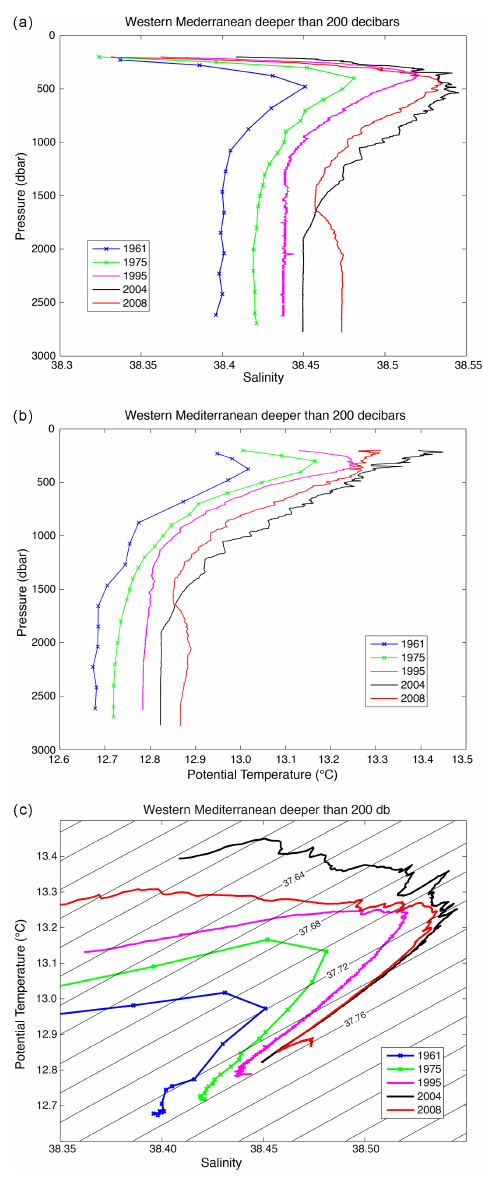
Figure 2. Profiles of (a) salinity and (b) potential temperature ver- sus pressure for historical stations at location A at the eastern en- trance to the Alboran Sea. (c) Potential temperature–salinity dia- grams for the historical stations with contours of potential density referenced to 2000dbar. Levantine Intermediate Water (LIW) is evi- dent as a salinity maximum at about 400dbar for each station. West- ern Mediterranean Deep Water (WMDW) is the deep water below 2200dbar at each station. The halocline–thermocline between the depth of the LIW at 400dbar and the top of the deep water be- low 1800dbar has a stratification where warm, saltier waters over- lie colder fresher waters and this stratification is conducive to salt finger mixing processes. Depth-averaged salinity, potential temper- ature and potential density referenced to 2000dbar below 200dbar are given for each station in Table